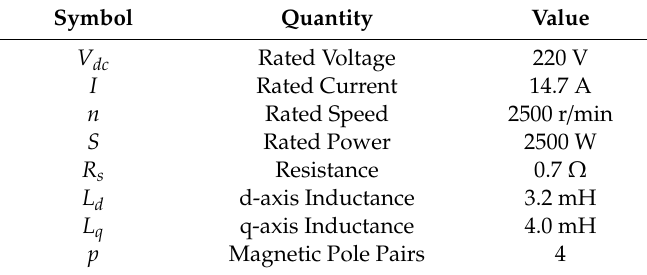
Figure 3. The simulation results of estimated extended back-EMF by the traditional second-order SMO sensorless control method for an IPMSM. ( a ) The actual speed n and the estimated speed; ( b ) the actual position of the rotor θ e and the estimated position; ( c ) the actual position of the rotor θ e and the estimated position; ( d ) the rotor position error waveform; ( e ) the extended back-EMF component of the rotor position information observed by the traditional second-order SMO; ( f ) the harmonic spectrum obtained by FFT. Table 1. Parameters of the tested